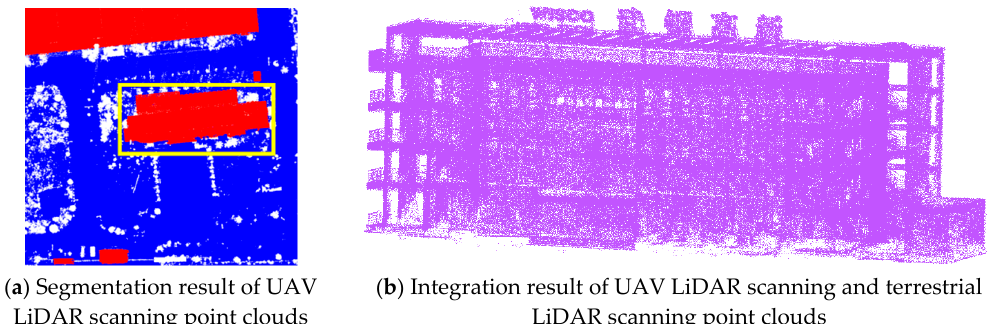
Figure 10. Building segmentation results from LiDAR scanning point clouds and integrated point clouds.